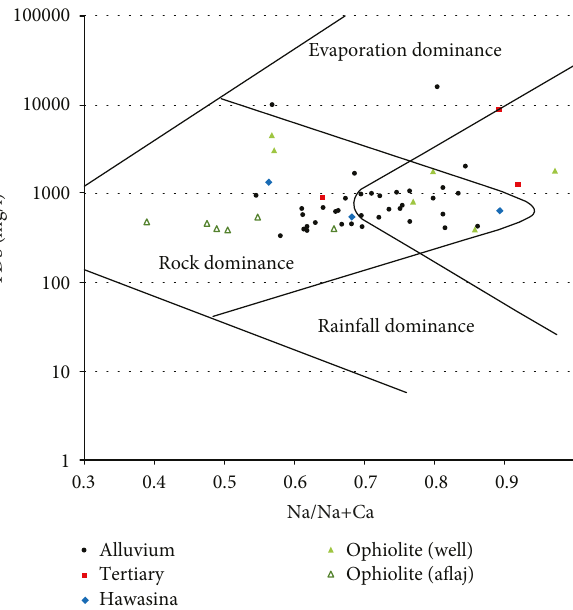
Figure 5: Gibbs diagram compares the role of evaporation and water-rock interaction processes on groundwater.